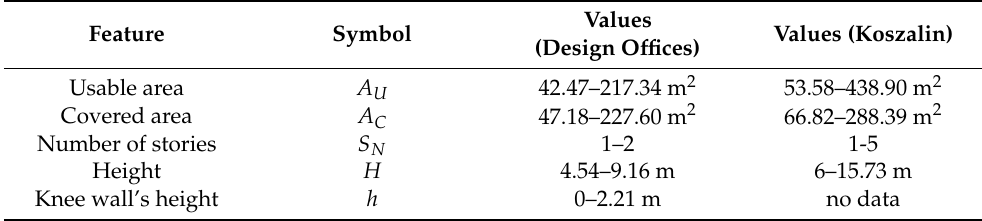
Table 1. Recorded features of 172 residential buildings from the architectural bureaus and of 24 houses in Koszalin with the range of values present in the